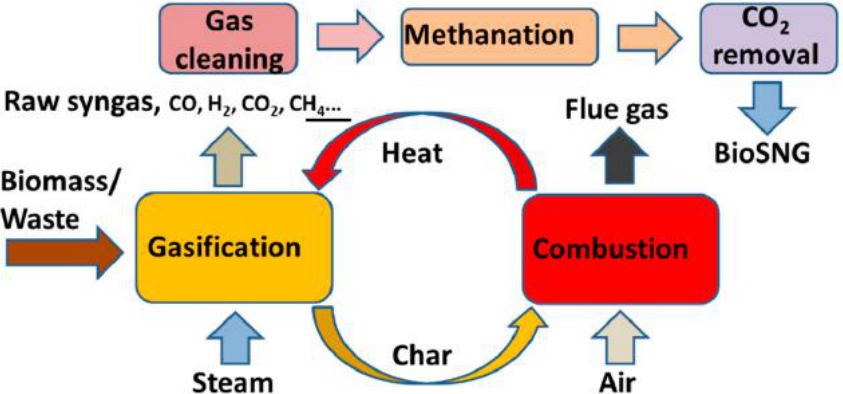
Figure 5. The concept of indirect gasification technology with the combustion process, reproduced from [41], with permission from MDPI Publisher.